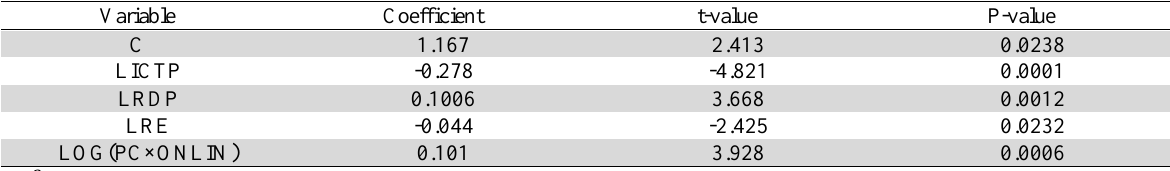
The summary of regression analysis of LERP as a function of LINLOS, LPER, LAGE and LBRA